Question: Name the type of graph shown.
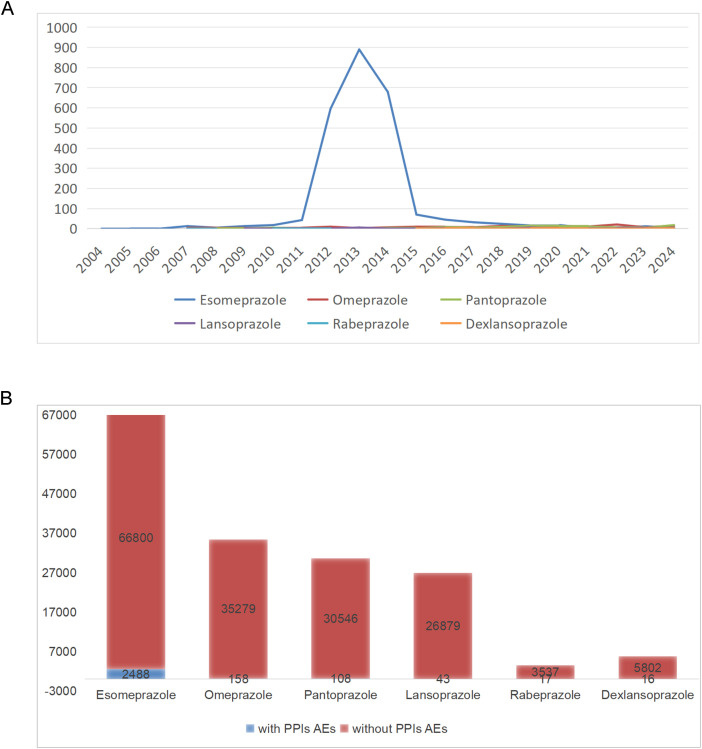
Answer: line